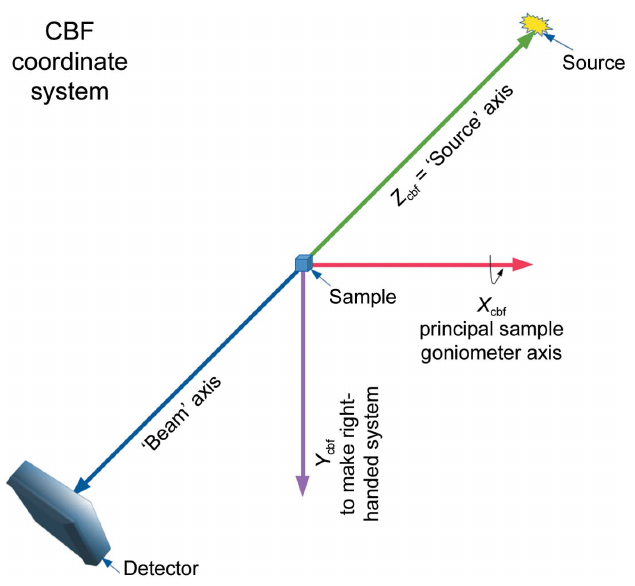
Figure 3 The standard coordinate frame in imgCIF/CBF aligns the X axis with the principal goniometer axis and chooses the Z axis to point from the sample into the beam, i.e. the ‘Source’ vector. If the beam is not orthogonal to the X axis, the Z axis is the component orthogonal to the X axis of the ‘Source’ (or ‘ (cid:5) Beam’) vector. The Y axis is chosen to complete a right- handed axis system. The origin is in the sample. It is important to note that the direction of the principal goniometer axis is a design choice in creating or even in configuring a crystallographic beamline. Even if we were to restrict our choices of principal goniometer axes to be horizontal, it is possible and equally valid to have CBF coordinate frames in which the Y axis points down, as in this figure, or to have CBF coordinate frames in which the Y axis points up, depending on the direction of the X